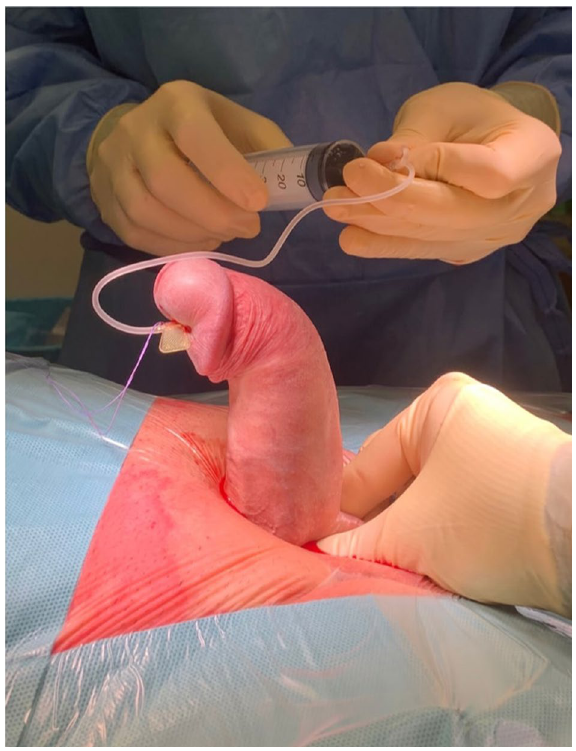
Figure 1. Identification of the maximum curvature point on the concave side of the penile shaft, through an artificial erection with saline